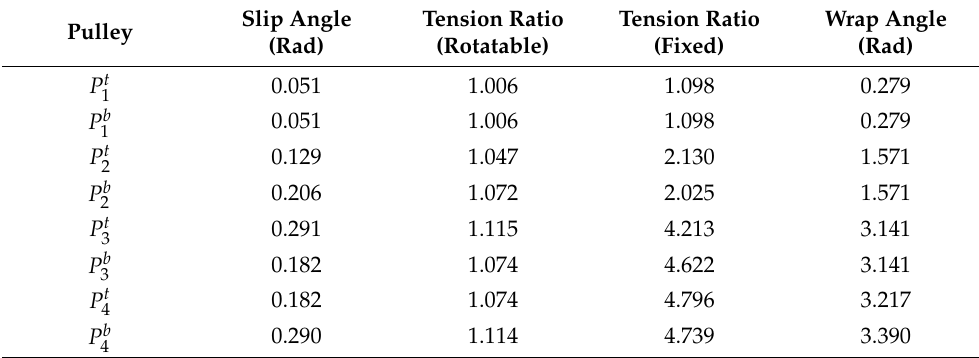
Table 3. Slip angles, wrap angles, and tension ratios of the cable wrapped pulleys.